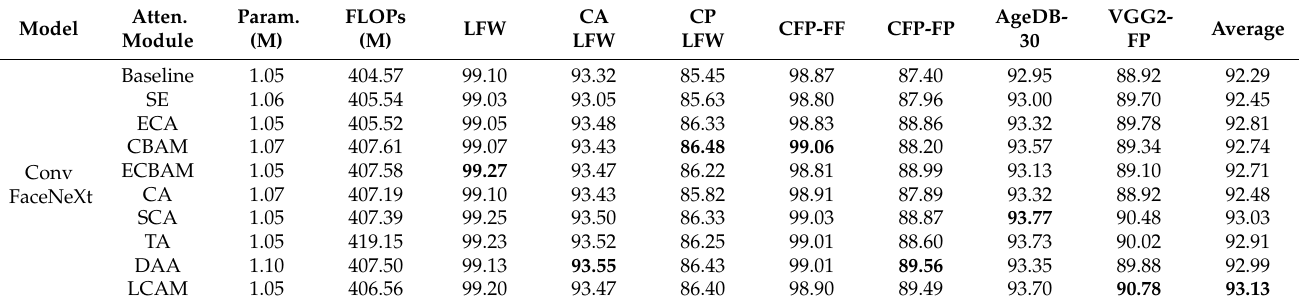
Table 7. Performance results of different attention modules plug into ConvFaceNeXt. These results are reported in terms of parameters, FLOPs and verification accuracy for LFW, CALFW, CPLFW, CFP-FF, CFP-FP, AgeDB-30 and VGG2-FP. Moreover, the average accuracy for the seven image-based datasets is shown in the last column. (Bold values are the highest obtained values by the methods). Atten. Model